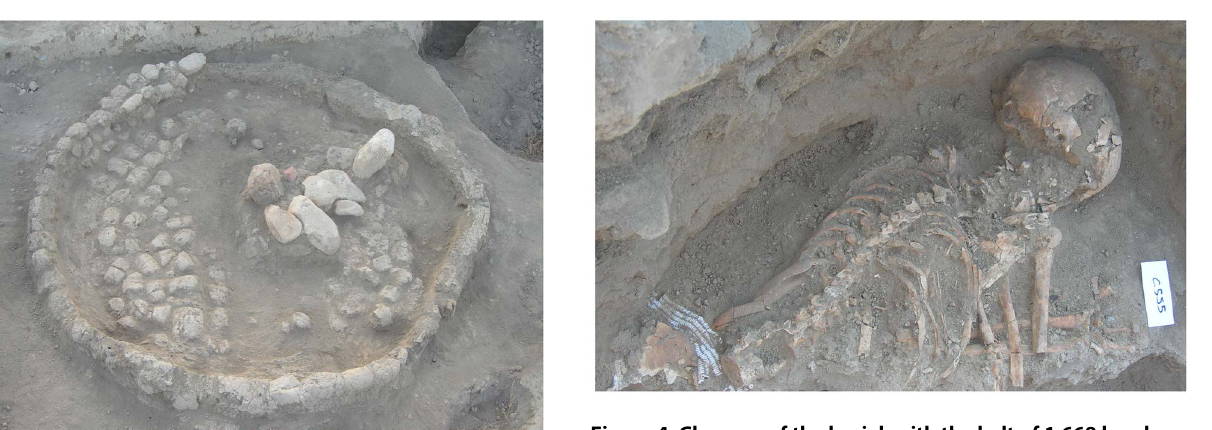
Figure 4. Close-up of the burial, with the belt of 1,668 beads on its pelvis.